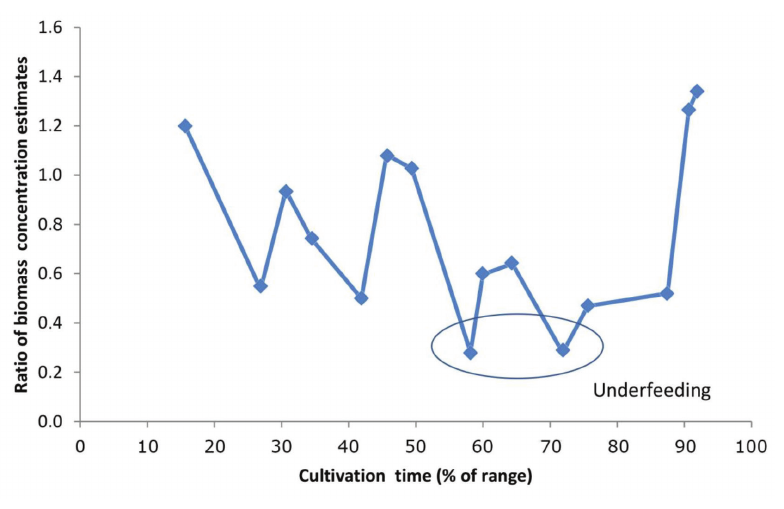
Fig. 10 – Ratio of biomass concentration estimates based on calorimetry and off-gas composition analysis in cultivation ΔCO 2